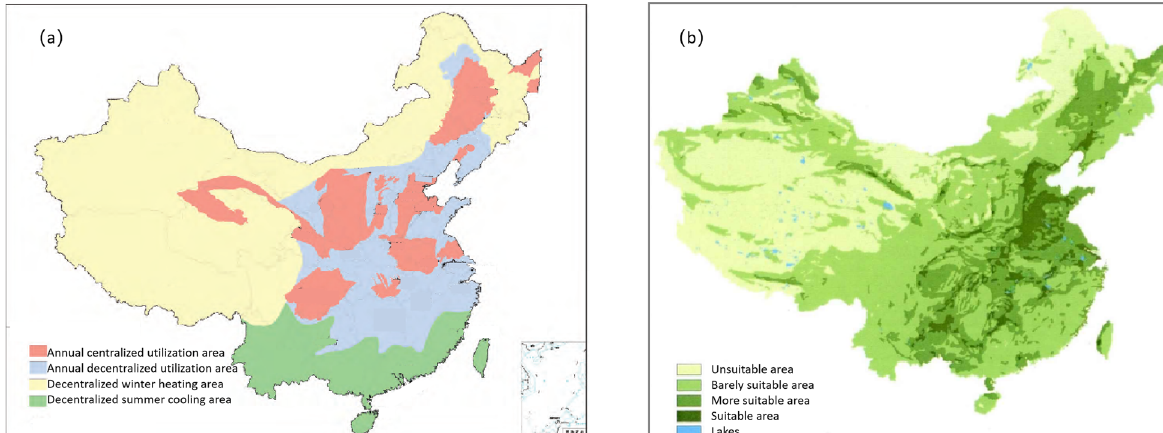
Fig. 5 Division of geothermal energy development and use in China [5]. a Division of shallow geothermal energy development and utilization zones in China; b Application suitability map of groundwater source heat pumps in